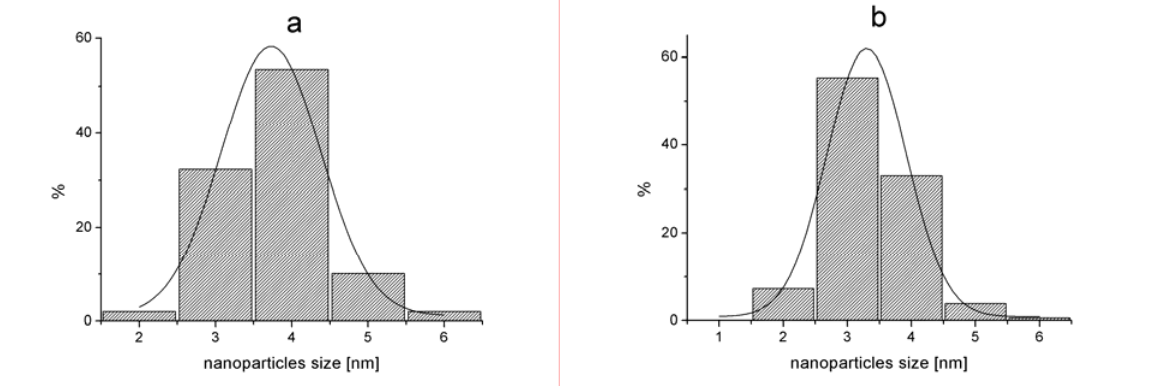
Figure 5. Pd(0) nanoparticles size analysis (a) G2-Pd, (b) G3-Pd.